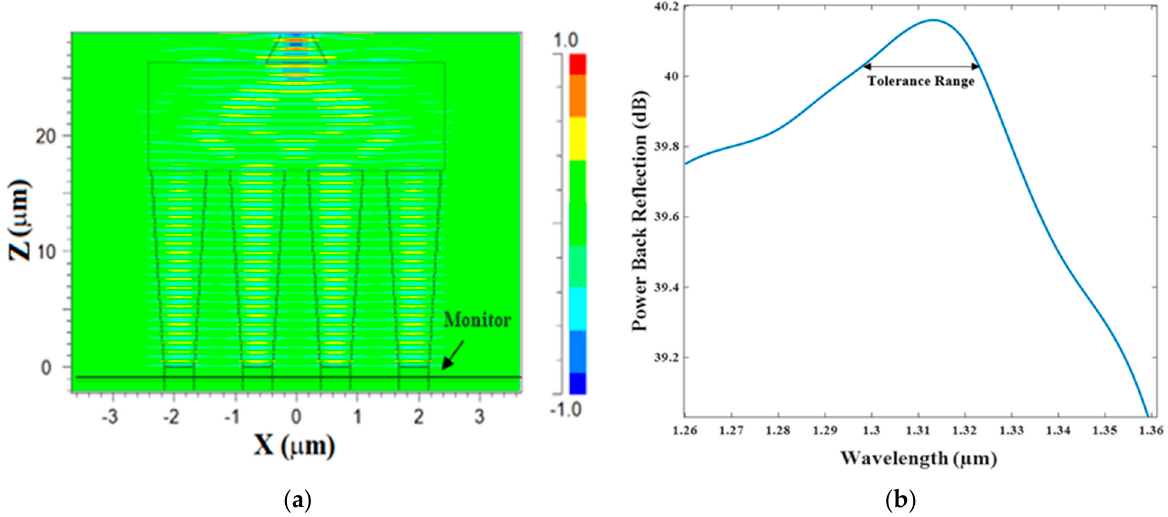
Figure 9. BR calculation using FDTD solver: ( a ) illustration of the simulation setup; ( b ) the power BR over the O-band spectrum.